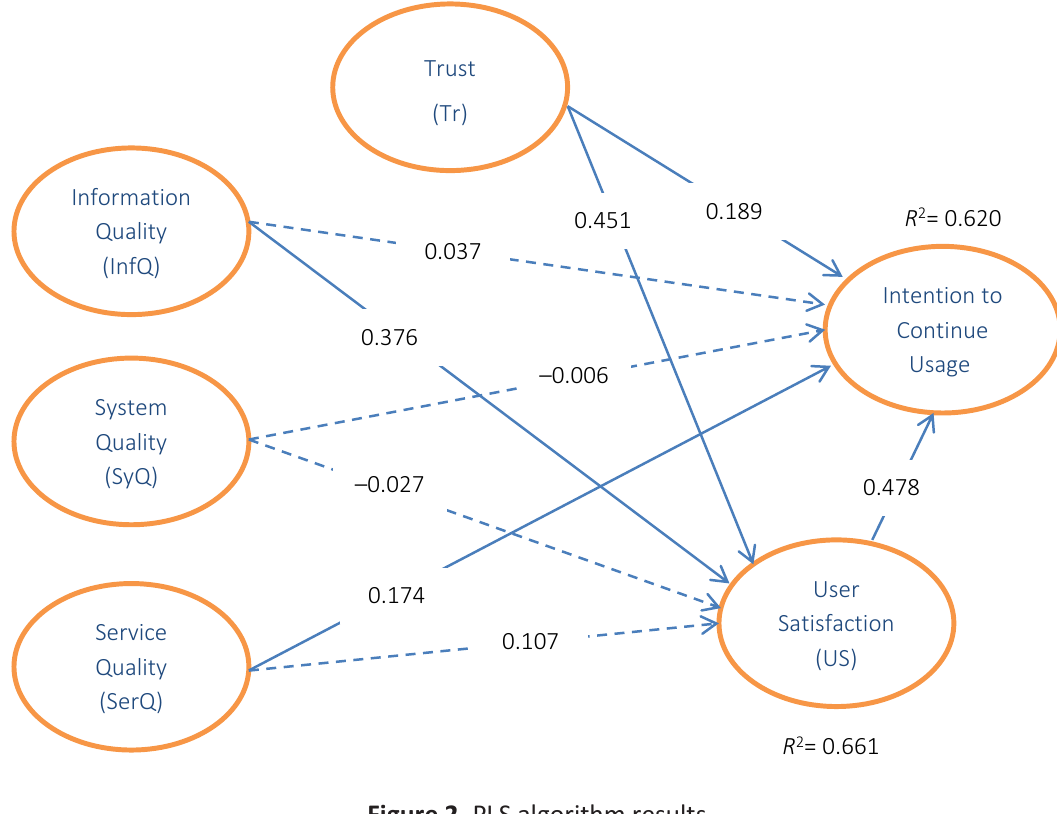
Figure 2. PLS algorithm results